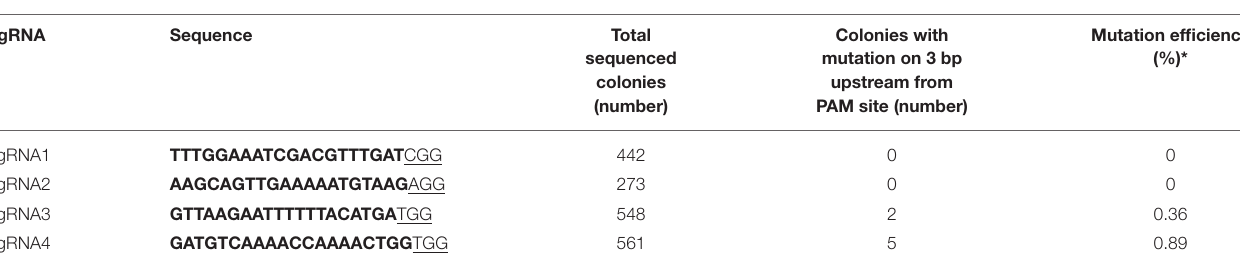
TABLE 1 | Mutation efficiency of sgRNAs targeting SlAPX4